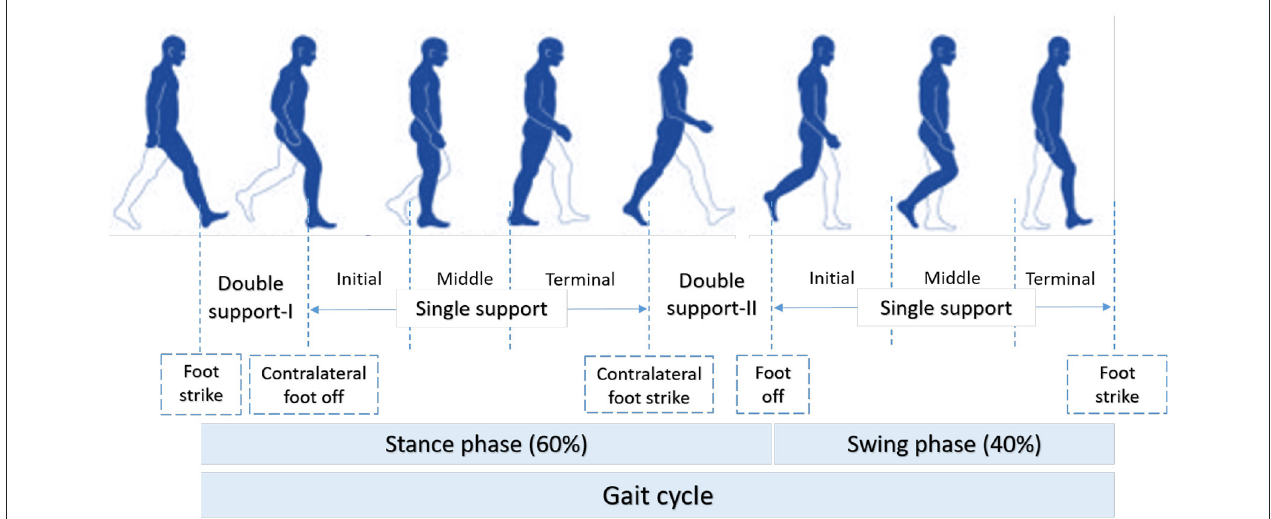
FIGURE 2 | Functional phases of a normal gait cycle according to